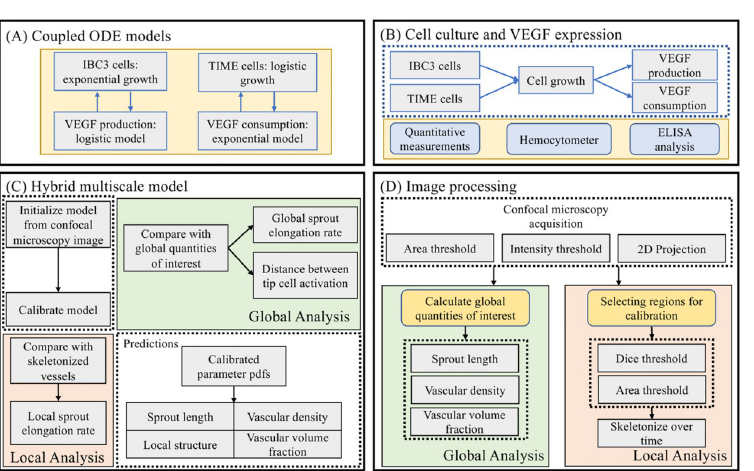
Fig 1. Schematic of computational and experimental methods. Fig 1A and 1B show the calibration of tumor and endothelial cell number and VEGF concentration to hemocytometer and ELISA measurements over time. Given the calibrated VEGF production and consumption rates, we inform our hybrid multiscale model, shown to Fig 1C, to confocal microscopy images of angiogenic sprouts, depicted in Fig 1D. We analyze the model globally, calibrating model parameters to summary statistics of the data, namely the sprout length and vascular density, and locally, calibrating the local stalk cell divide time to segmented vascular structures. This sequential approach, starting with protein concentration and cell number experiments to inform the hybrid model prior to integrating confocal microscopy images, allows us to utilize experimental data at multiple scales to inform the multiscale nature of the tumor angiogenesis